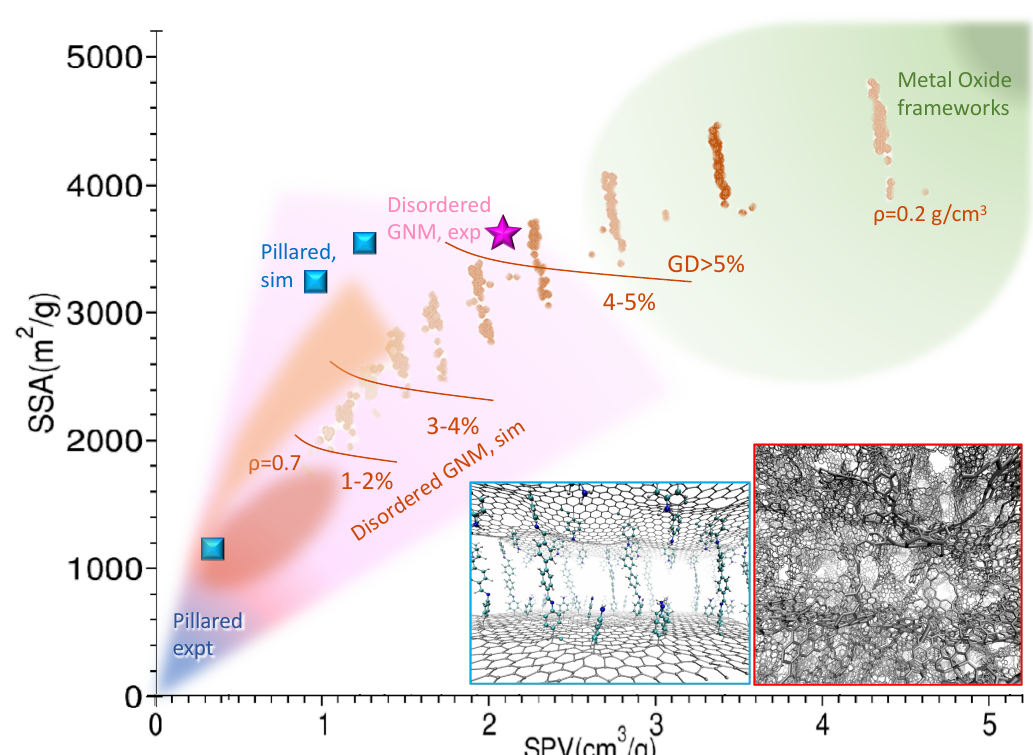
Figure 1. Structure diagram of graphene-based nanoporous materials (GNMs). The Specific Surface Area (SSA) vs specific pore volume (SPV) is reported for various experimental determinations and simulation studies. The blue shaded area encloses the experimental determinations of pillared structures, the one shaded in pink encloses the area spanned by experimental determinations of the disordered GNM sca ff olds, both from various literature works cited in the text and in Table 2 (magenta star: Ref. [44]). The squared blue dots are simulations for pillared materials (Refs. [74,76,80]). Brown and reddish shades and dots are from simulations. The brown dots are preliminary from ref. [55], and roughly accumulates on lines at di ff erent decreasing density (smaller and larger simulated density are reported); red oval shade and orange shade are extracted and processed from ref. [74]. The brown lines separate areas at increasing excess GD evaluated at 77K. The region typically spanned by the Metal Oxide Frameworks is reported in green. Sample structures for the pillared (blue border) and disordered GNM (red border) are reported as